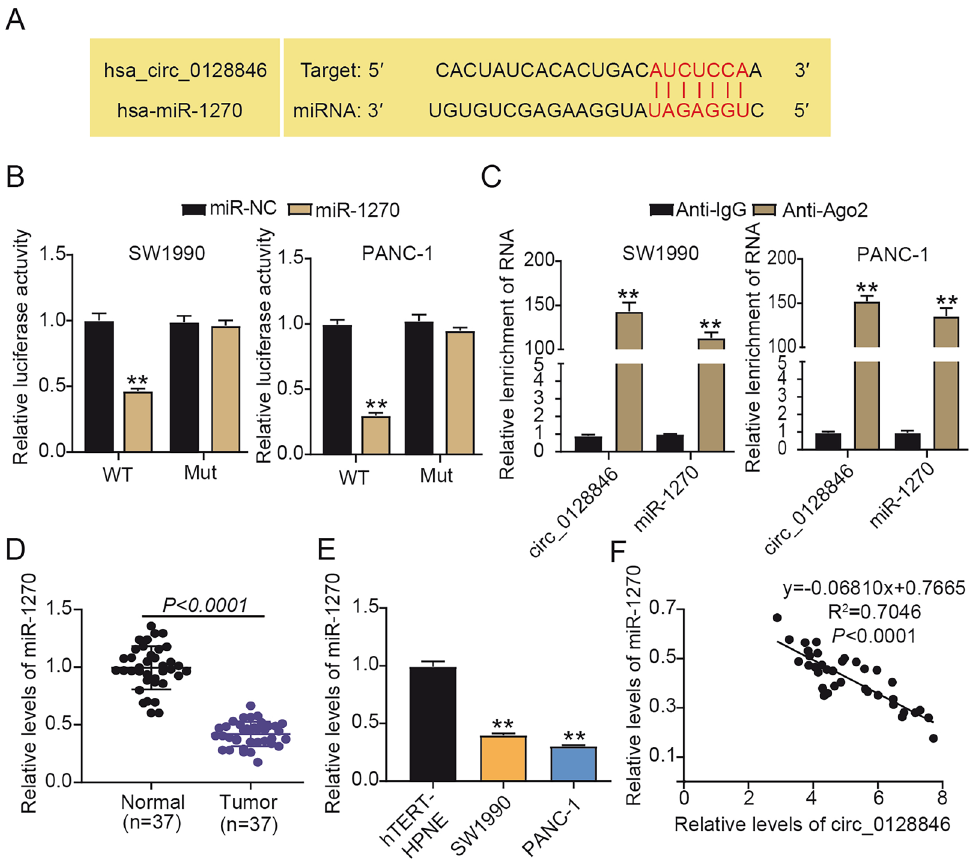
Figure 4. MiR-1270 was a direct target of circ_0128846. ( A ) The binding site between miR-1270 and circ_0128846 was predicted by circinteractome. ( B ) The binding relationship between circ_0128846 and miR- 1270 was further testified by dual-luciferase reporter assay. ** P < 0.001 relative to miR-NC. ( C ) The binding relationship between circ_0128846 and miR-1270 was vertified by RIP assay. ** P < 0.001 relative to Anti-IgG. ( D ) MiR-1270 expression in tumor samples and normal samples was examined by RT-qPCR. ( E ) MiR-1270 expression in PC cell lines (SW1990 and PANC-1) and control cell line (hTERT-HPNE) was examined by RT-qPCR, ** P < 0.001 relative to hTERT-HPNE. ( F ) The linear relationship between miR-1270 and circ_0128846 expression in tumor samples was analyzed by Pearson’s correlation